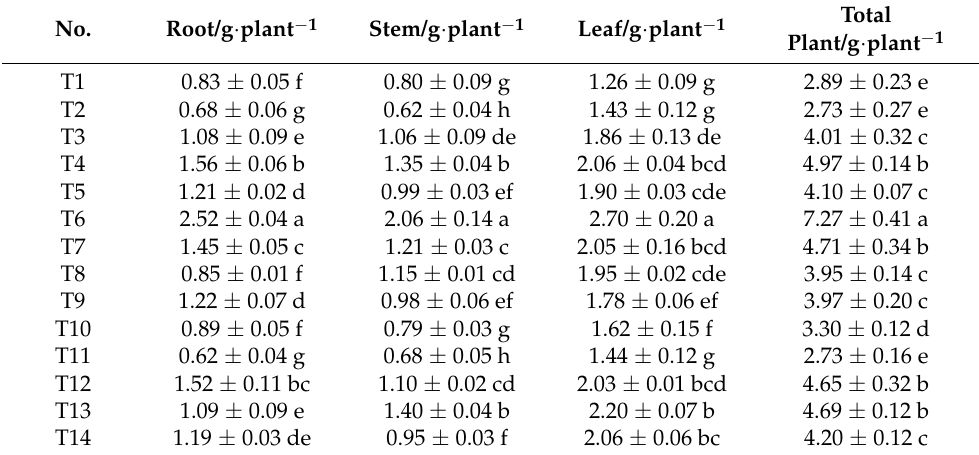
Table 2. Dry biomass accumulation of P. bournei seedlings under different N-P-K fertilization (Reprinted from ref.